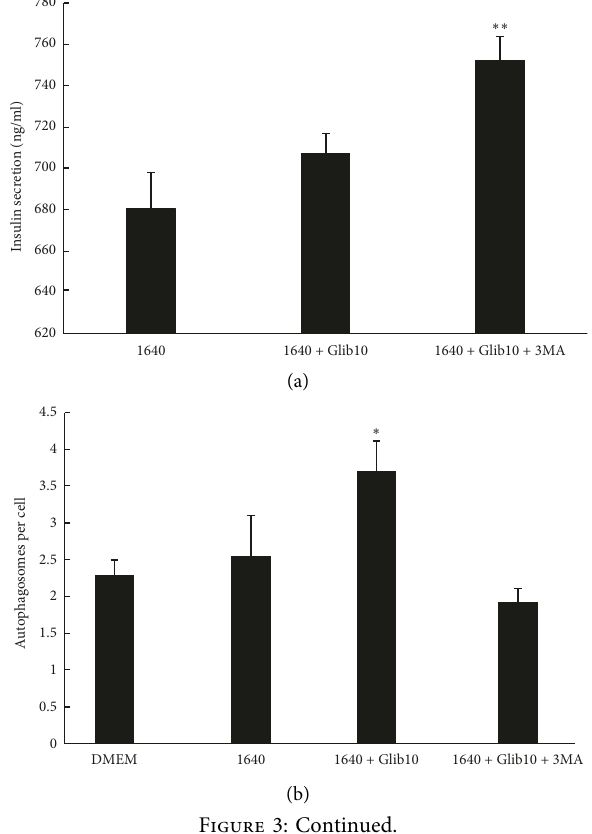
P 0 . 01, 1640 vs. 1640+Glib10. Data ∗∗ <